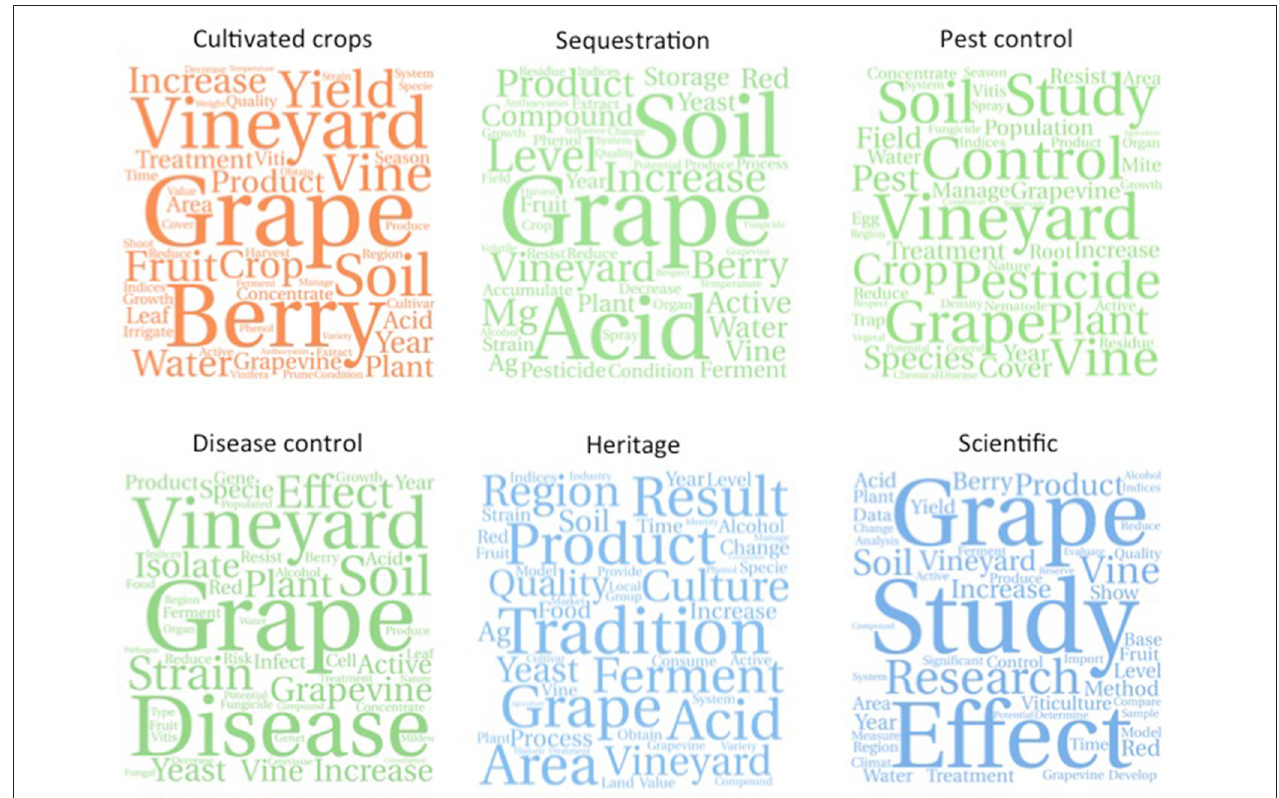
FIGURE 4 | Word clouds for the six key vineyard ecosystem services we identified in existing research. For each word cloud, the abstracts of the publications (raw hits) of the CICES ecosystem service class shown in the title were used. The size of the font is determined by absolute frequency of the word in the abstracts of this ecosystem service. Provisioning services are shown in orange, regulating and maintenance in green, and cultural in